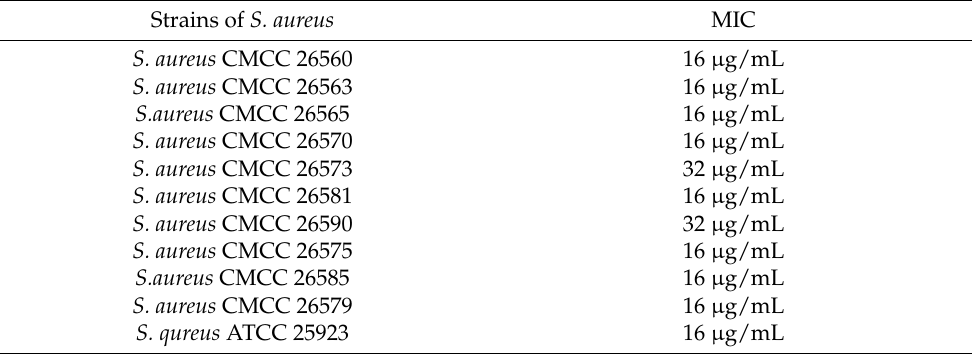
Table 1. MIC of plantaricin YKX against S. aureus . Strains of S.